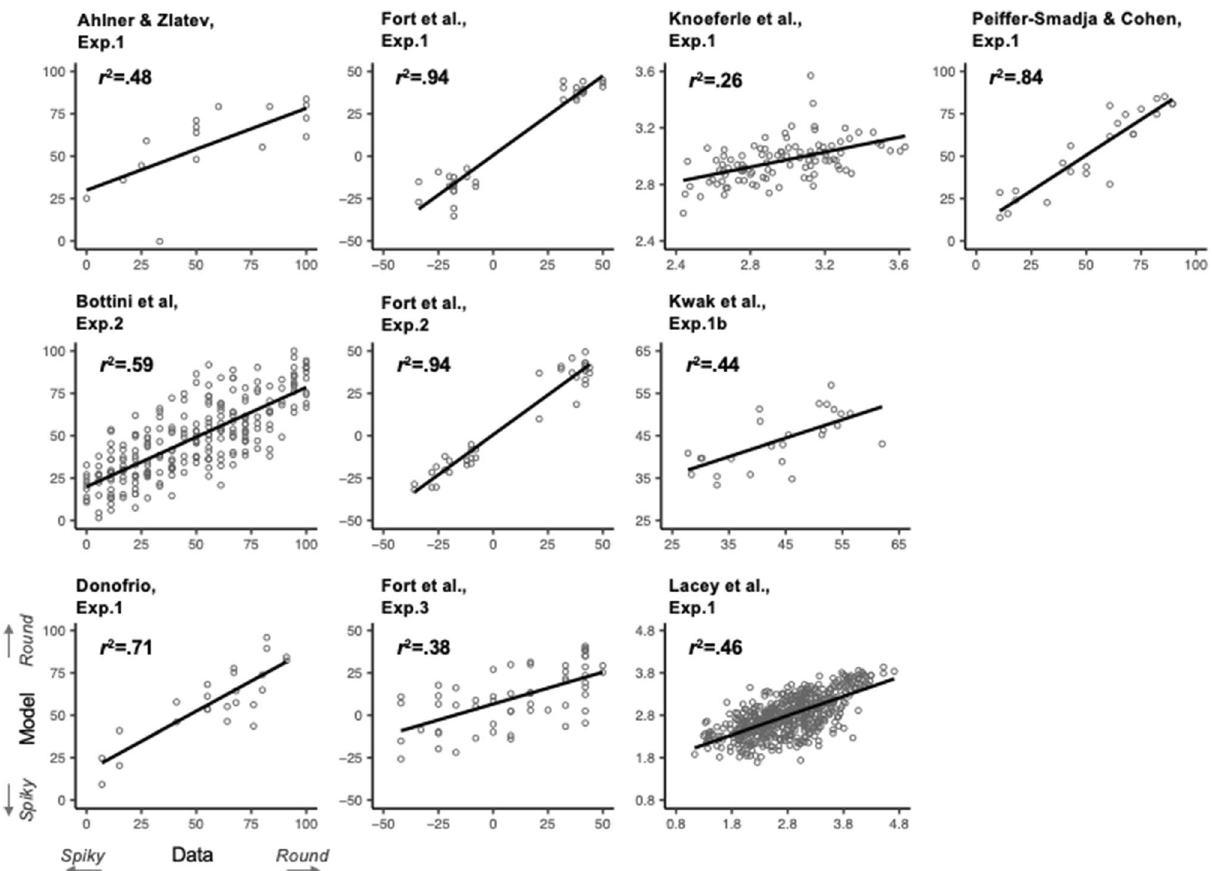
Experiments r 2 % Standard error t p N Table 1. Statistical analysis of the linear regression fits for the 10 already published experiments and the Noise band experiment (synthetic non-speech stimuli) as well as their number of stimuli N. For each fit with the optimal Balance-Continuity model (or just Balance in the case of some studies 16,24 Knoeferle et al., Exp. 1 and Kwak et al., Exp. 1b, respectively) displayed in Fig. 2, the corresponding t and p values for the estimation of explained variance r 2 are provided.